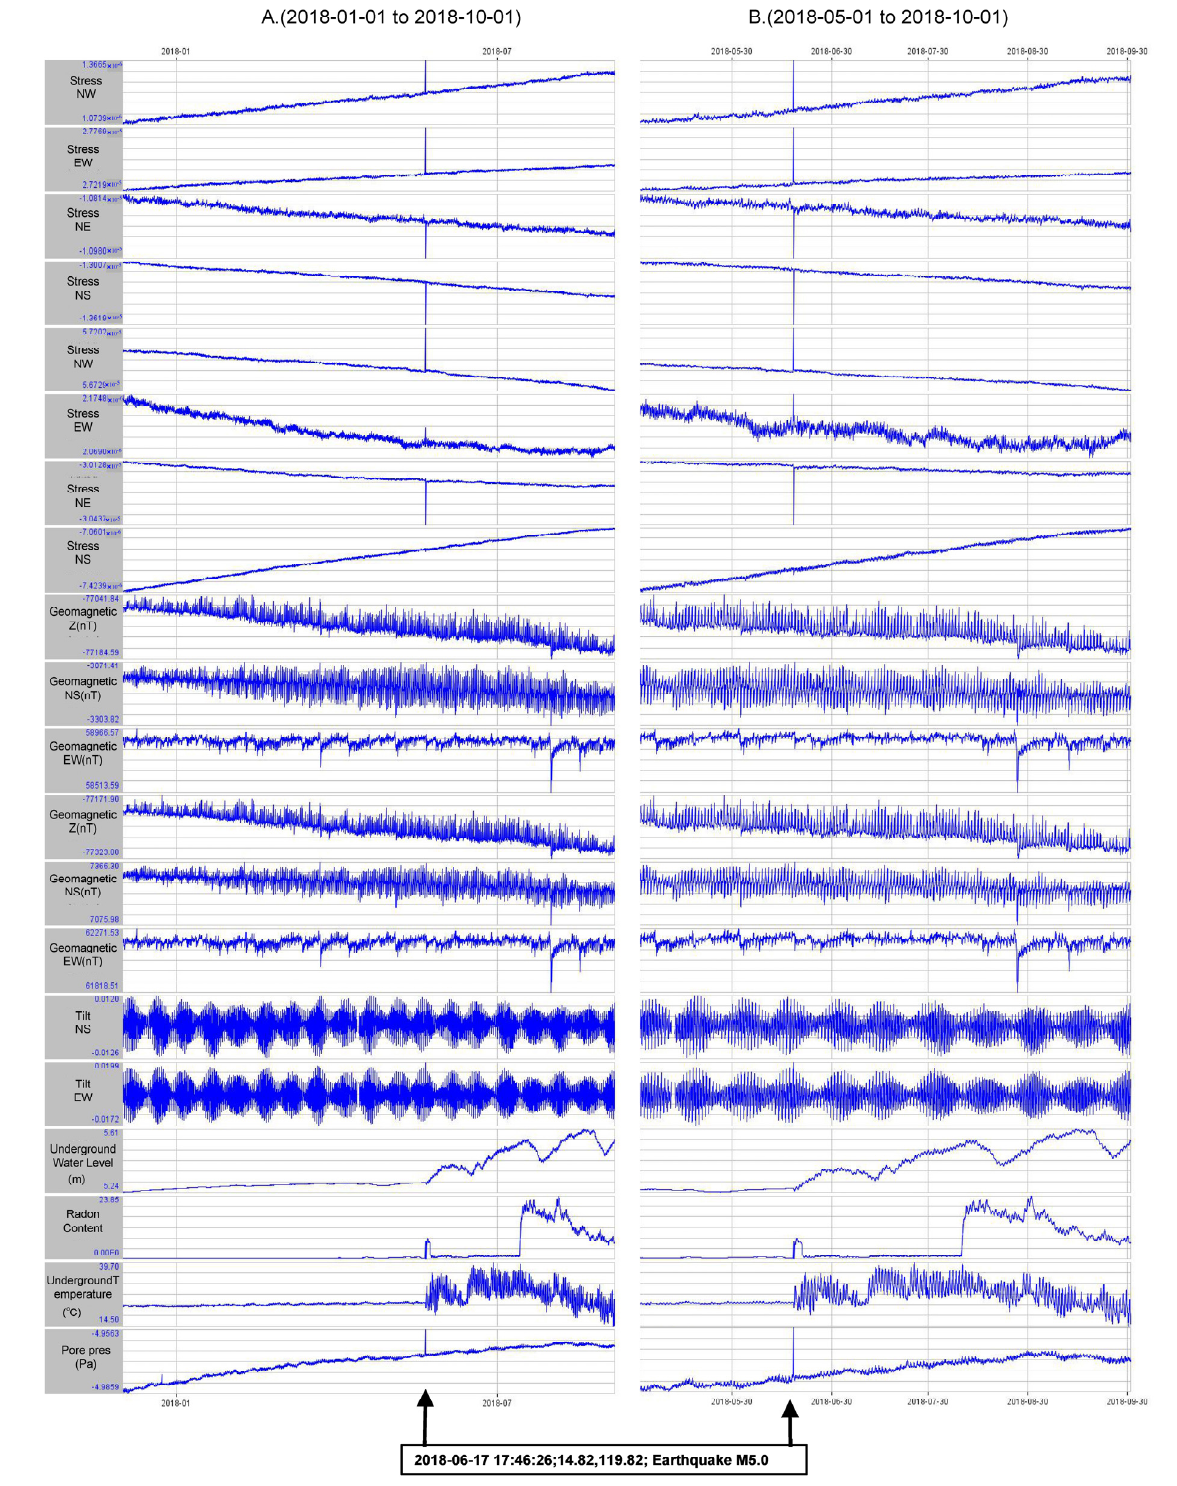
Figure 4. Records of underground monitoring parameters before and after the Philippine magnitude-5 earthquake. The monitoring parameters from the top to the bottom are as follows: the in situ stress components of eight azimuths, geomagnetic field components of six azimuths, the earth tilt components of two azimuths, underground water level, gas radon content, underground formation temperature and pressure, and pore pressure.